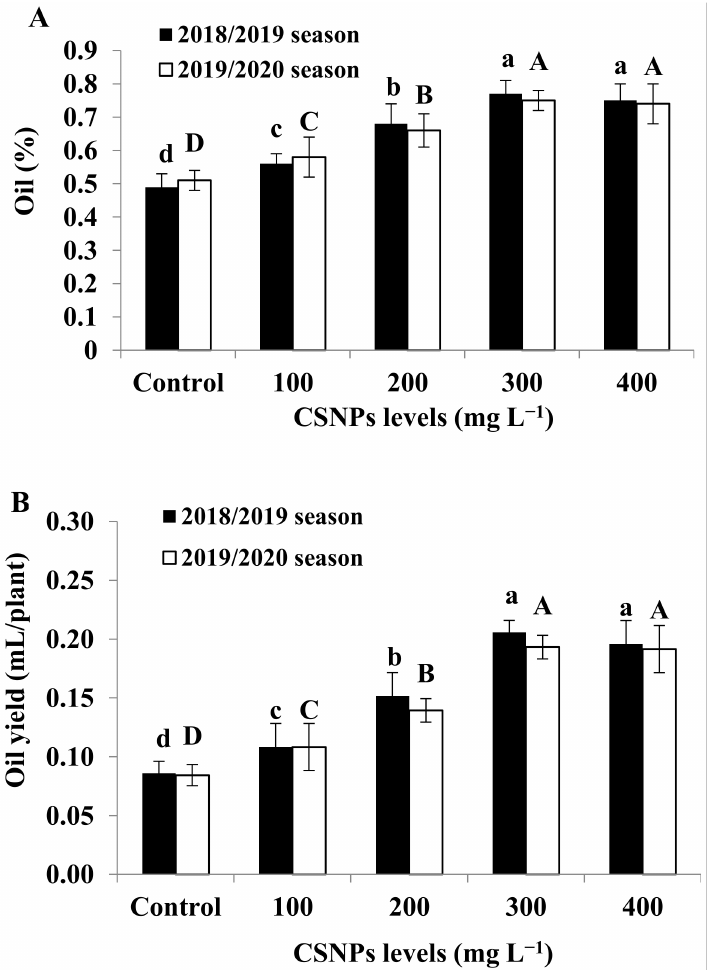
Figure 2. Impact of chitosan nanoparticles (CSNPs) on ( A ), essential oil percentage; ( B ), essential oil yield/plant of Matricaria chamomilla in the two experimental seasons. Data are means ± SE ( n = 3). In each season, letters represent statistical differences among the treatments at 5%